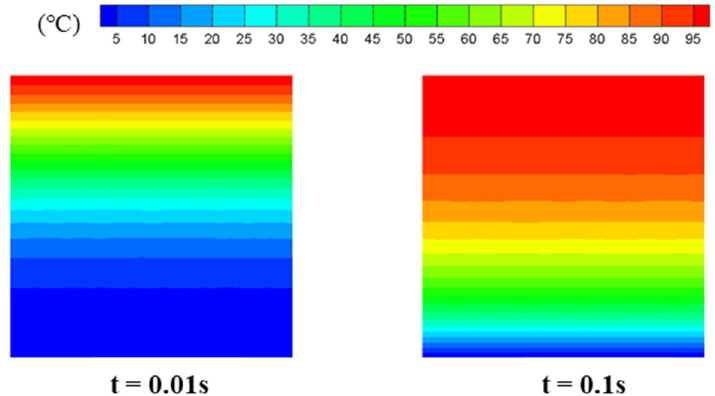
Figure 13. Temperature distribution inside the FGM plate at different times.